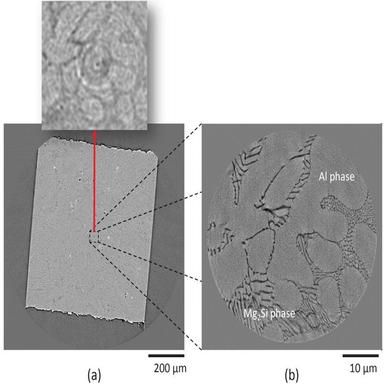
Slice images of multi-scale CT (beamline 20XU in SPring-8) in Al-7Mg2Si cast alloy. X-ray energy of 20 keV was used. Magnified nano-CT image of (b) can be obtained in large size specimen for micro-CT shown in (a).